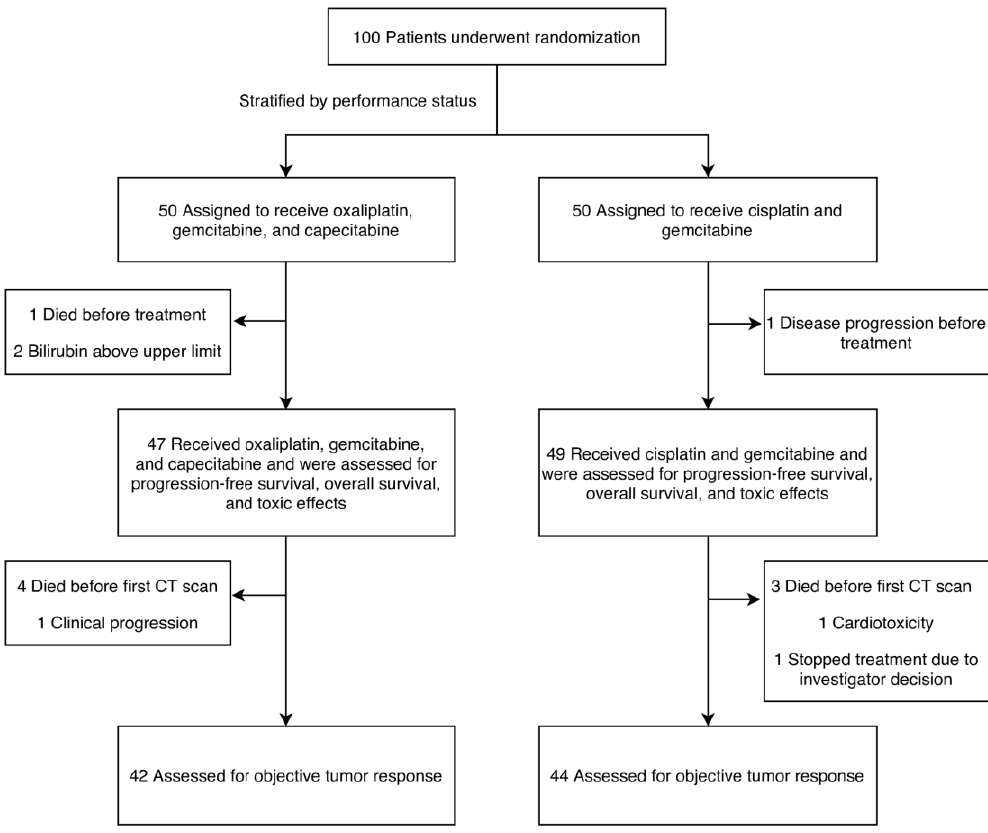
Figure 1. Patient enrollment, randomization, and treatment. CT — computerized tomography. Table 1. Baseline characteristics of the study participants, according to the treatment group.